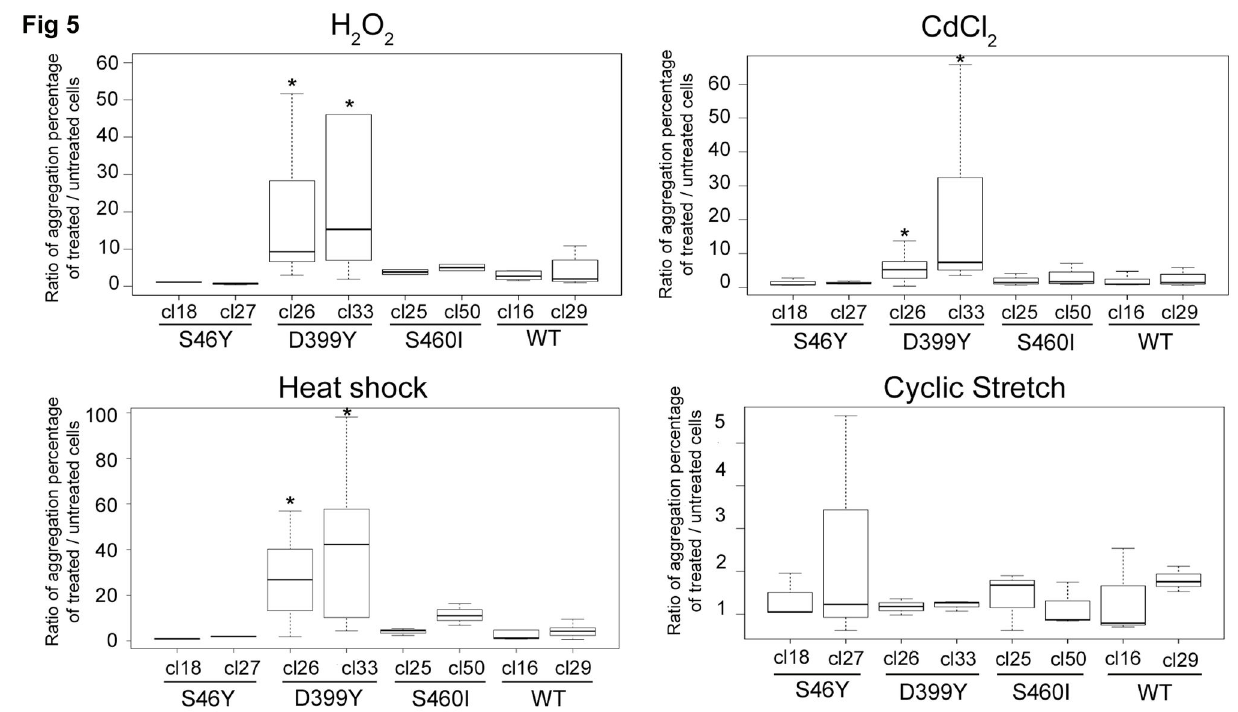
Figure 5. Stress experiments results. Quantification in box plot of cells containing aggregates 24 h after stress (T desmin WT or mutated Tet-On constructs. Four different treatments are shown: oxidative (H mechanical (cyclic stretch). Cell counting was performed on at least three independent experiments (over 100 cells each). Significant differences to both WT clones are indicated with asterisk (p<0.05) calculated with non-parametric test. “Cl-Number” represents the name of the selected clone for each desmin mutation. doi: